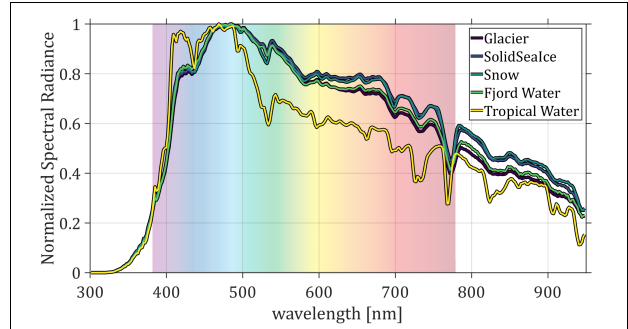
FIGURE 8 | Surface-leaving spectral radiance, normalized by peak radiance, including the effects of reflected sky radiance and anomalous sun glint. The ‘Tropical Water’ trace represents a measurement made in the equatorial Pacific Ocean while the others represent measurements made from a flight over Svalbard, Ny-Ålesund. The faded rainbow in the background indicates the color of visible light for each wavelength.